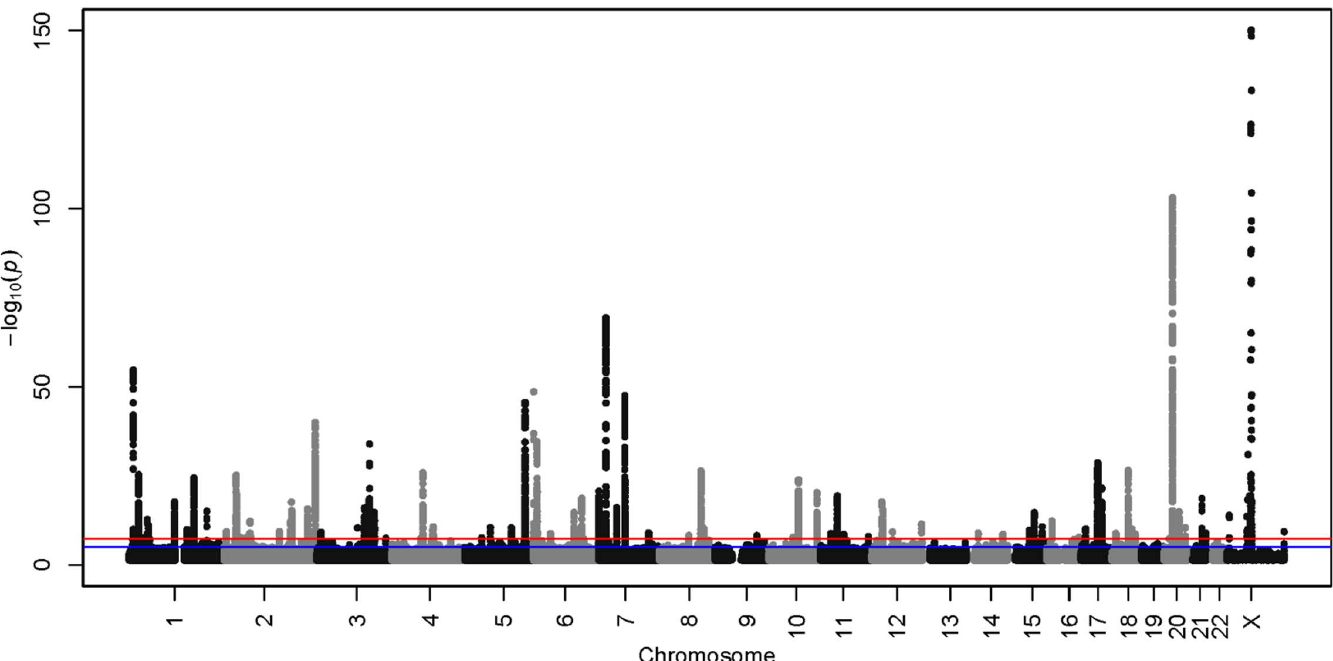
Fig 1. Manhattan Plot of imputed autosomal GWAS and genotyped X chromosome of male pattern baldness (p-values truncated at 1x10 -150